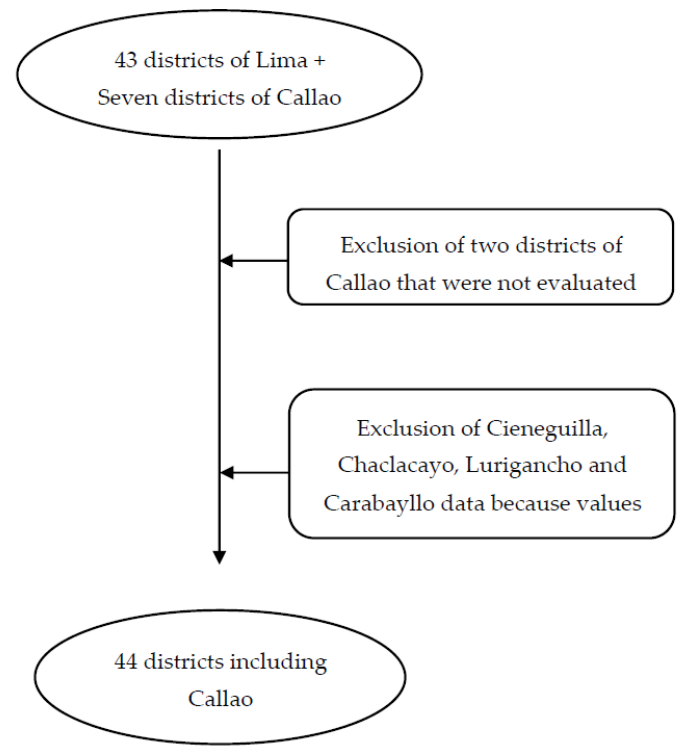
Figure 1. Environmental data exclusion flowchart.